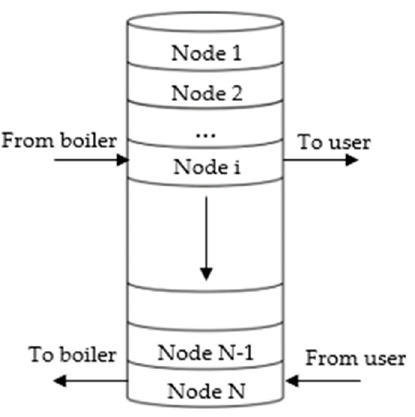
Figure 1. Liquid storage tank schematic representation for the multi-node modeling approach.